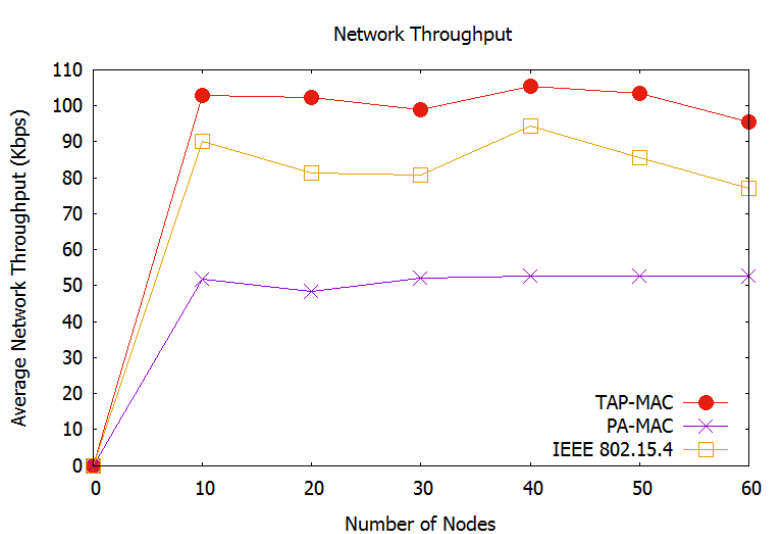
Figure 11. Scenario-2 average network throughput.